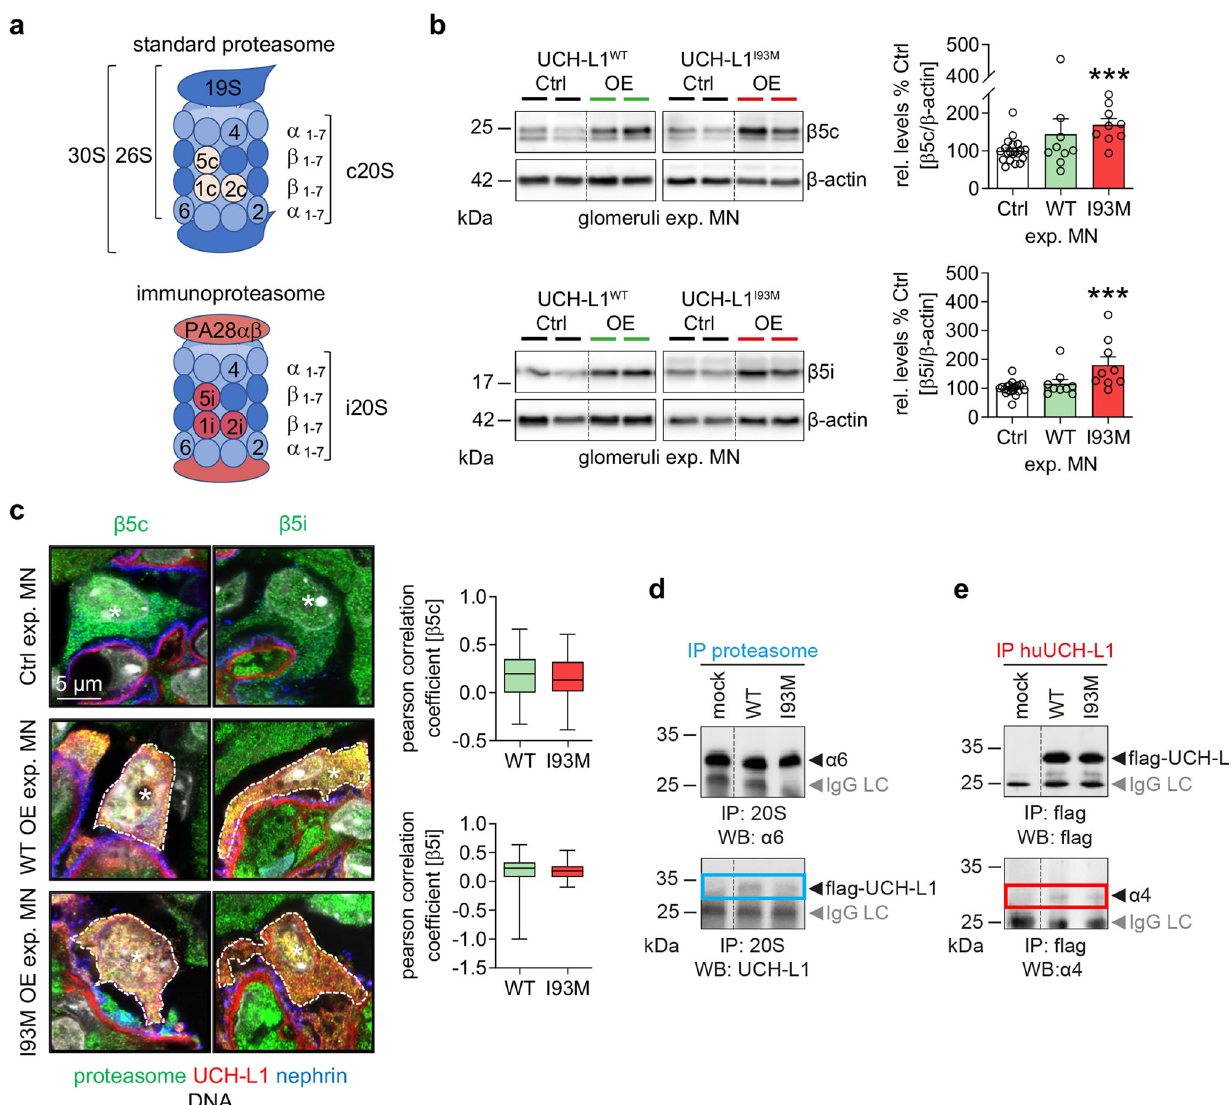
Fig. 7 | UCH-L1 interacts with the proteasome. a Scheme of the standard pro- teasome (proteolytic subunits β 1c, β 2c and β 5c) and of the immunoproteasome (proteolytic subunits β 1i, β 2i and β 5i). b , c Experimental MN was induced by i.v. injection of sheep anti-murine podocyte antibodies (AP-abs) in UCH-L1 over- expressing (WT OE and I93M OE, respectively) and their littermate (Ctrl) mice. Kidneys were collectedon day 14. b Glomerularimmunoblot analysesofmain( β 5c and β 5i) proteasomalsubunitabundancenormalized to β -actin. Pooledvalues of 4 independent experiments (WT-UCH-L1, n =20 Ctrl or n =9 WT OE) or of 2 inde- pendent experiments (I93M-UCH-L1, n =20Ctrlor n =9 I93MOE) for each subunit are shown as mean+/-SEM, *** p =0.0004 ( β 5c), *** p =0.0002 ( β 5i), two-tailed Mann Whitney U test. c Confocal images showing co-localization of respective proteolytic proteins (green) withUCH-L1(red) in podocytes (marked by asterisks). Nephrin (blue) was used to depict the glomerular fi ltration barrier and DNA was stained with Hoechst (grey). Graphs: semiquantitative analysis of spatial proximity of β 5c and β 5i with UCH-L1 in selected podocytes (yellow overlay in framed area),